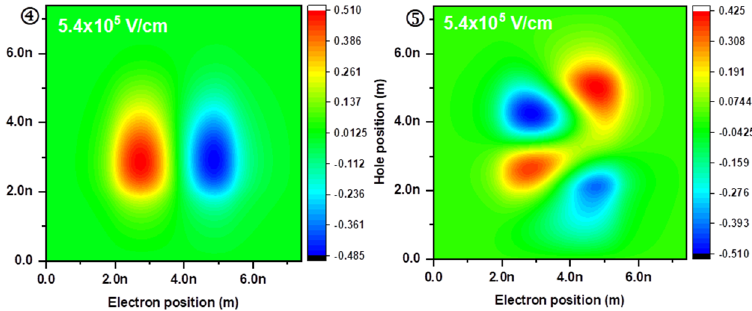
Figure 4. Spatial wavefunction distributions ( a ) without and ( b ) with an external electric field of 5.4 × 10 5 V/cm. In the figures, 1 (cid:13) – 5 (cid:13) indicate the first, second, third, fourth, and fifth lowest energy state,